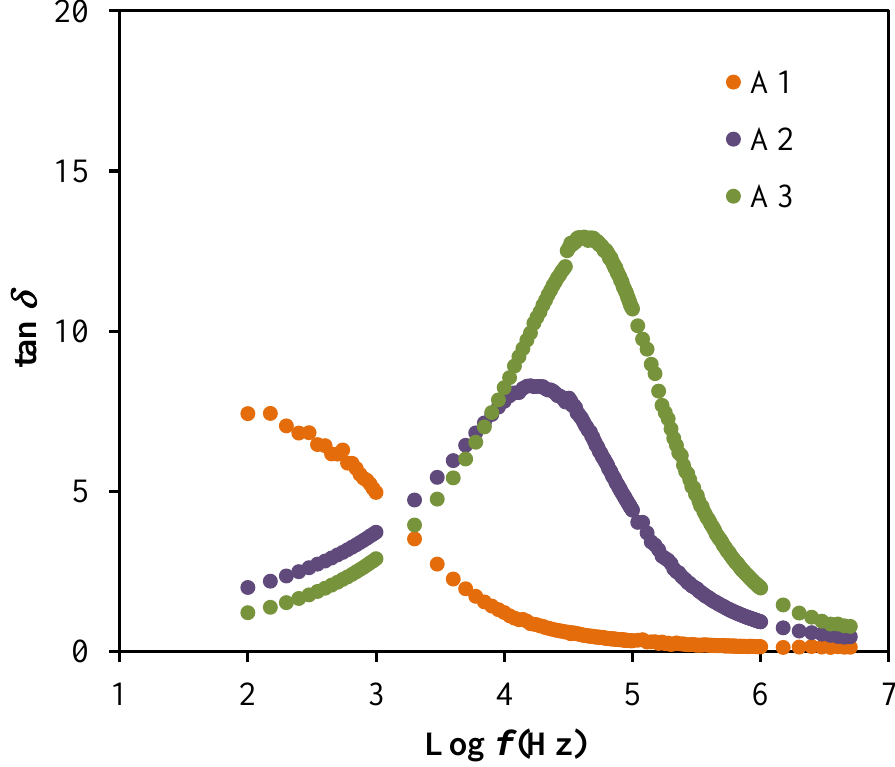
Figure 5. The plot of tan δ with respect to log f .